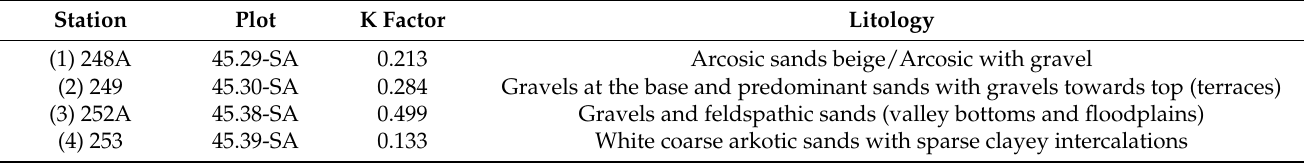
Table 1. Values of the K factor depending on the lithologies validated for the study area. Station Plot K Factor Litology 0.213 Arcosic sands beige/Arcosic with gravel 0.284 Gravels at the base and predominant sands with gravels towards top (terraces) 0.499 Gravels and feldspathic sands (valley bottoms and floodplains) 0.133 White coarse arkotic sands with sparse clayey